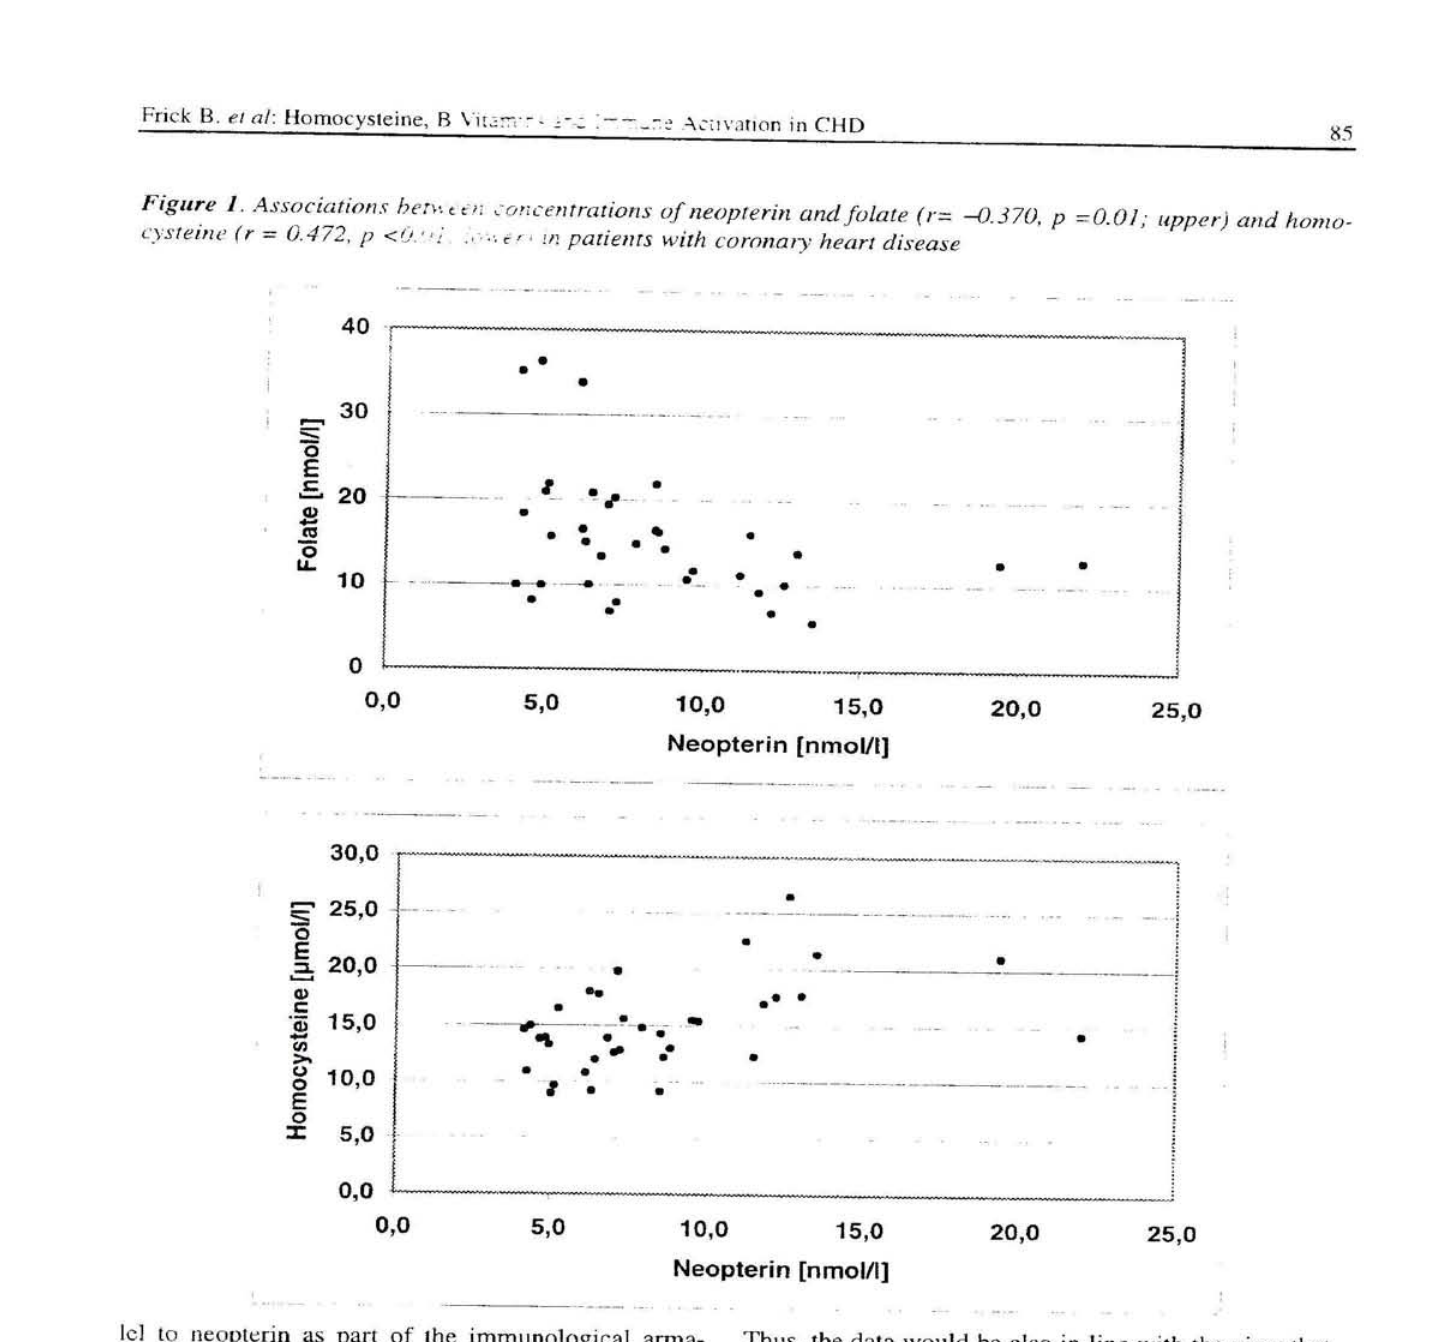
Figure 1. Associations beaten concentrations of neopterin and folate (r= -0.370, ρ =0.01; upper) and homo- cysteine (r - 0.4/2, ρ <0. '.v.·.·. in patients with coronary heart f /·.